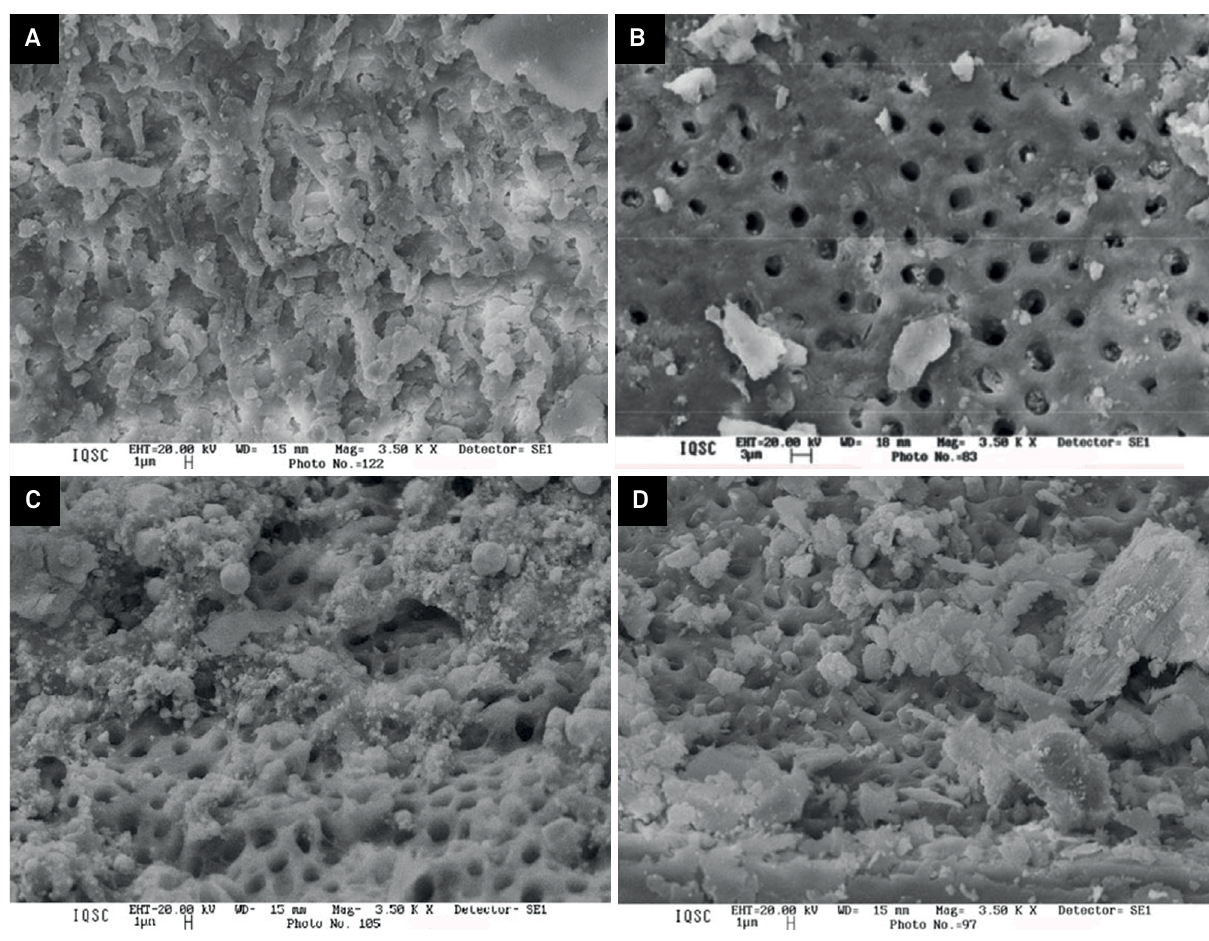
Figure 2. SEM micrographs of the root canal thirds after filling material removal in the different experimental groups. ProTaper alone (A): the root canal wall is covered by residual filling material in the three root canal thirds. PTR/ xylol (B): canal walls with exposed dentinal tubules. PTR/ orange oil (C): filling material remnants and exposure of dentinal tubules. PTR/eucalyptol (D): root canal walls with filling material remnants and exposure of dentinal